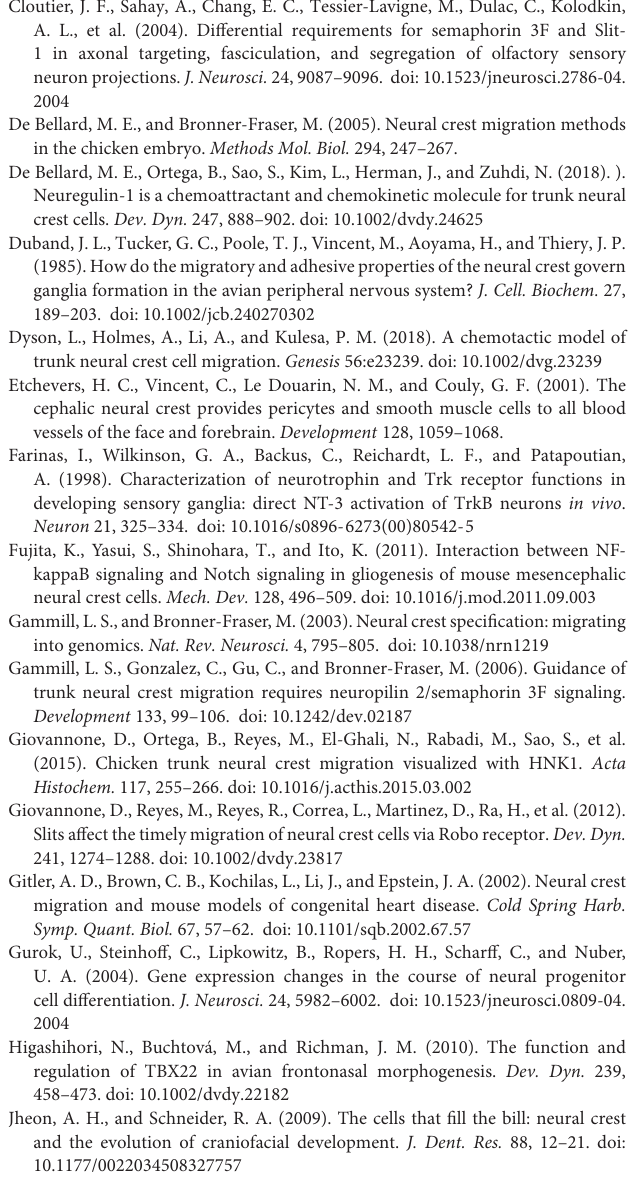
TABLE S3 | Q-PCR primers. TABLE S4 | Key resources